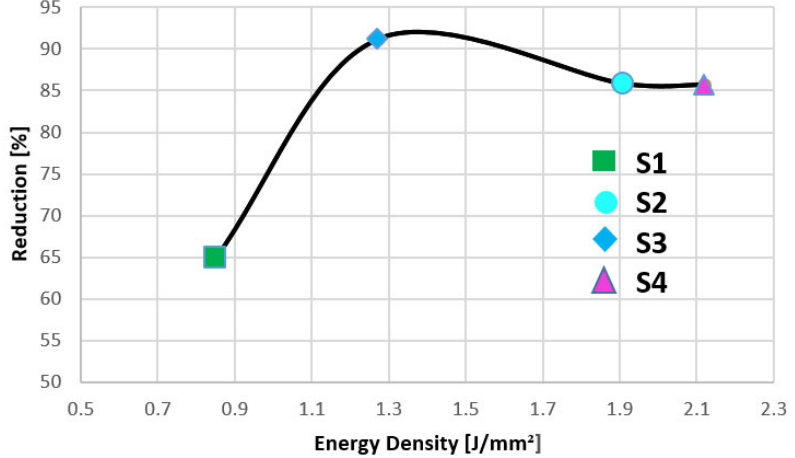
Figure 8. Variation in surface roughness reduction (measured at 90°) with energy